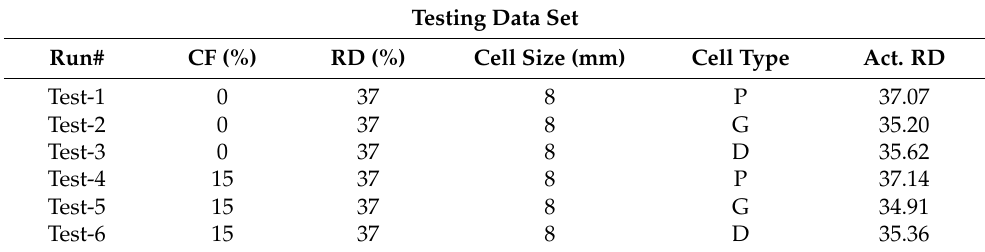
Table 9. Testing data